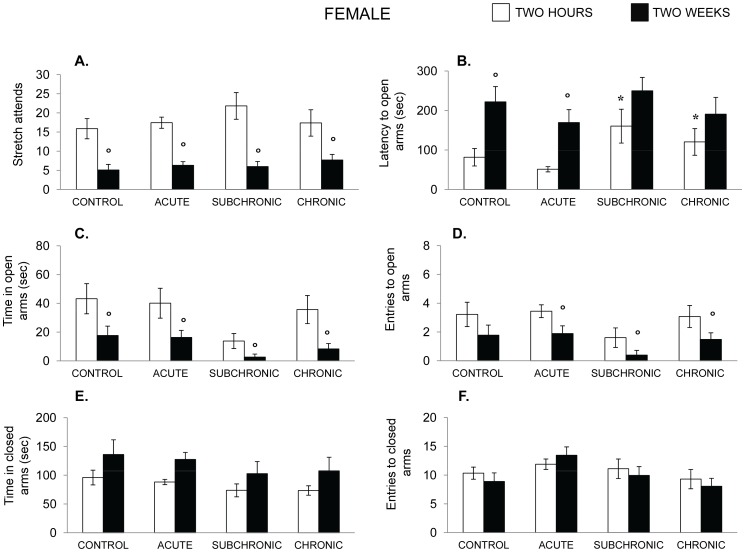
Effects of chronic, subchronic-intermittent and acute stressors on anxiety-related behaviors in female mice.Mean (± SEM) stretch attend responses (A), latency to enter the open arms (B), Time in the open Arms (C), Number of entries into the open arms (D), Time in the closed arms (E) and number of entries into the closed arms 2 he and again 2 weeks following treatment. Female mice had either not been stressed (control), exposed to an acute stressor (resident intruder paradigms for the two sexes), a sub subchronic-intermittent chronic stressor followed by the resident-intruder paradigm, or a chronic stressor followed by the resident-intruder stressor. *p<.05 relative to nonstressed mice. o p<.05 relative to performance measured 2 hr following the treatment.